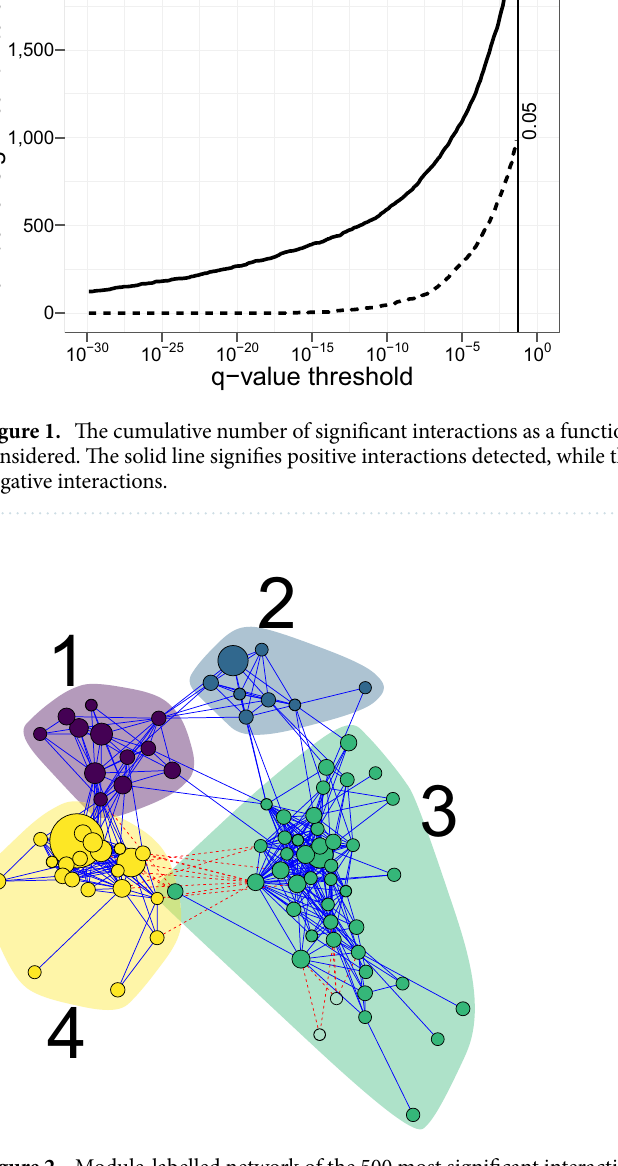
Figure 2. Module-labelled network of the 500 most significant interactions in the r / K -selection-switch dataset. Each of the 86 nodes is an OTU, while each edge corresponds to a statistically significant association between the OTUs. Blue solid edges indicate positive interactions, whereas red dashed edges indicate negative interactions. The node-sizes are scaled logarithmically according to overall mean